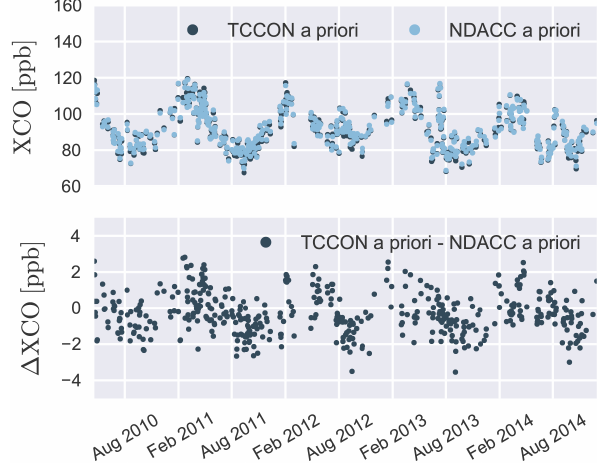
Figure 6. Same as Fig. 5 for XCO retrieved from NIR spectra using the TCCON retrieval strategy with changed a priori VMR